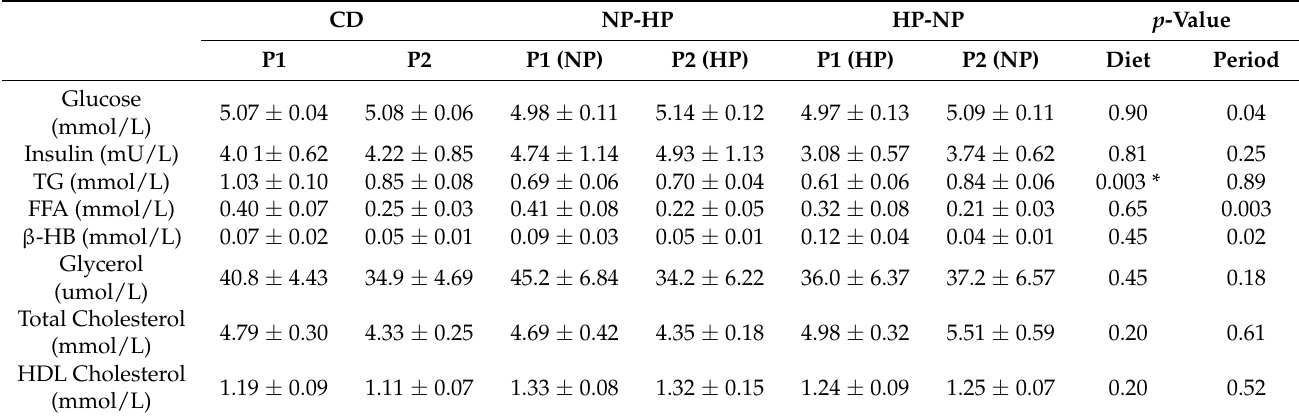
Table 2. Fasted plasma concentrations, determined from venous blood in all groups. CD NP-HP HP-NP p